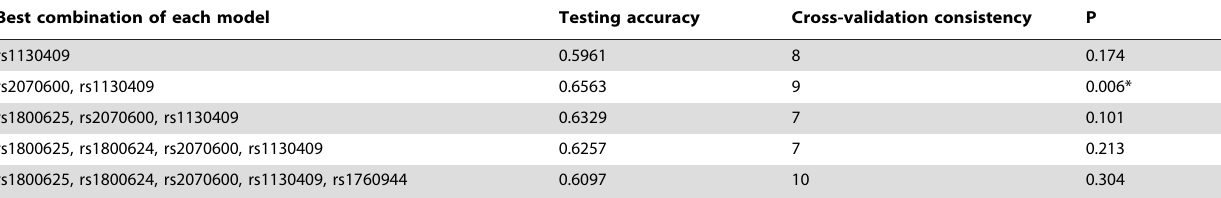
Table 4. Summary of MDR